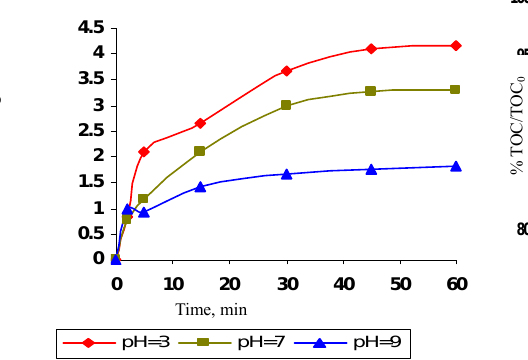
Figure 7. Changes of TOC during catalytic ozonation of 4NCB at different pHs. [ZnO] = 300 mg/L; [O ] = 5.64 o 3 o mg/L; [4NCB] = 15 o